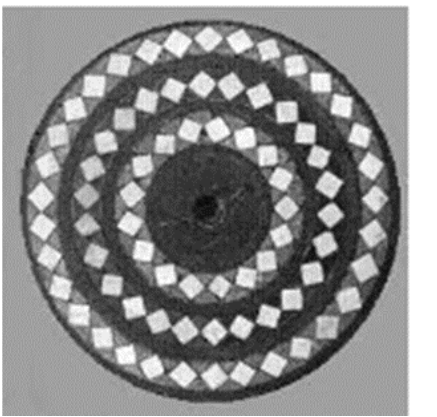
Figure 4-3 Gaming disk, Predynastic Period. Figure 4-4 Board game, New Kingdom